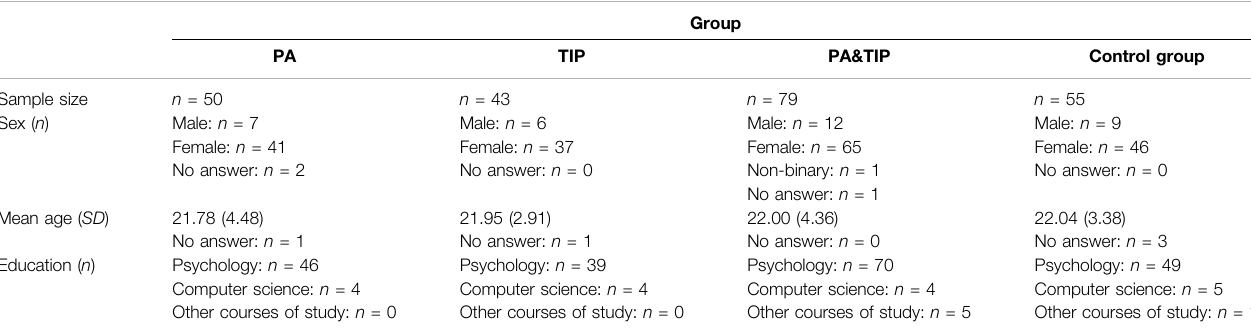
TABLE 2 | Number and demographics of participants (women and men) in the fi nal sample of the four experimental groups. Group PA TIP PA&TIP Control group Sample